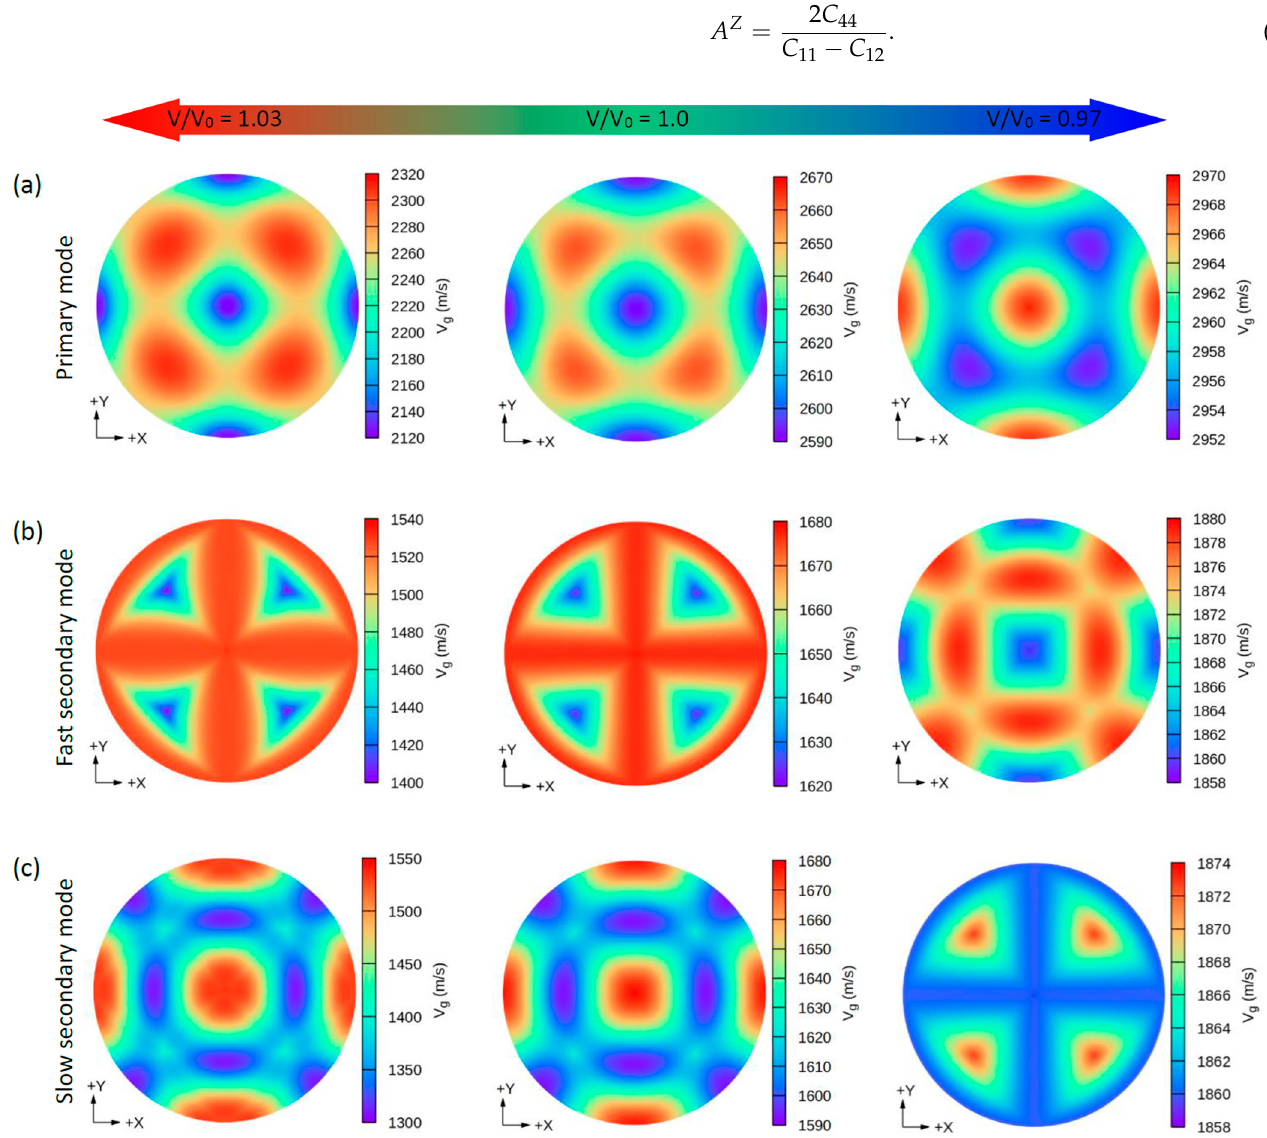
Figure 6. The calculated 2D directional dependence of the group wave velocity (V g ) in (xy)/(001)-plane for the CsNa 2 Bi compound. There are two types of acoustic wave velocities, i.e., the longitudinal wave velocity and the two transverse wave velocities in two directions. The single primary mode ( a ) is the longitudinal wave velocity and the two secondary modes, namely, fast secondary ( b ) and slow secondary ( c ), correspond to the transverse wave velocities. Although under hydrostatic tension no change is observed in the propagation patterns of the V g , in hydrostatic compression, these patterns change significantly.